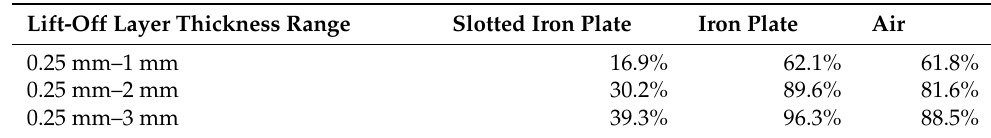
Figure 14. Relationship between the normalized LMF B x and the thickness of the lift-off layer for the slotted iron plate, iron plate, and air lift-off layer. Table 3. Comparison of attenuation speed with slotted iron plate, iron plate, and air lift-off layer under different thickness variation